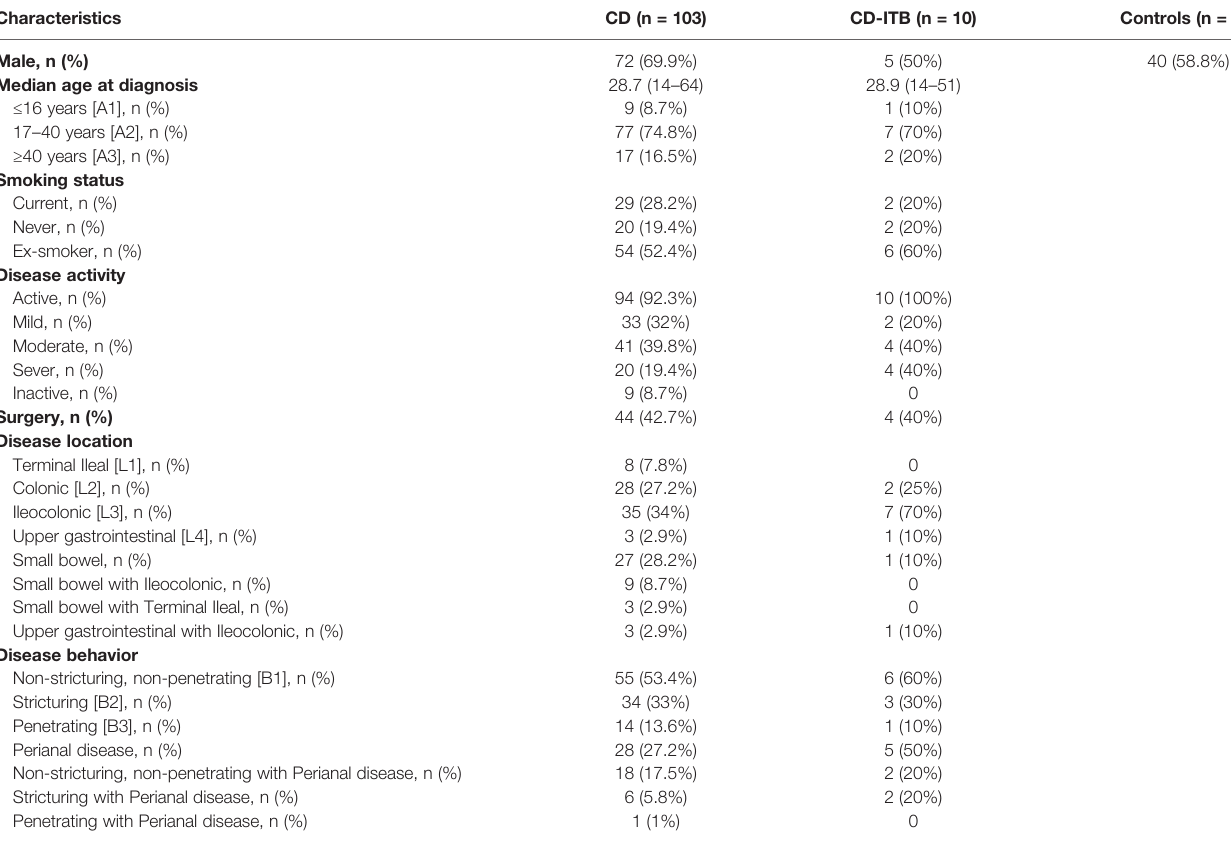
TABLE 1 | Demographic and main baseline characteristics of CD patients, CD combined ITB and controls.